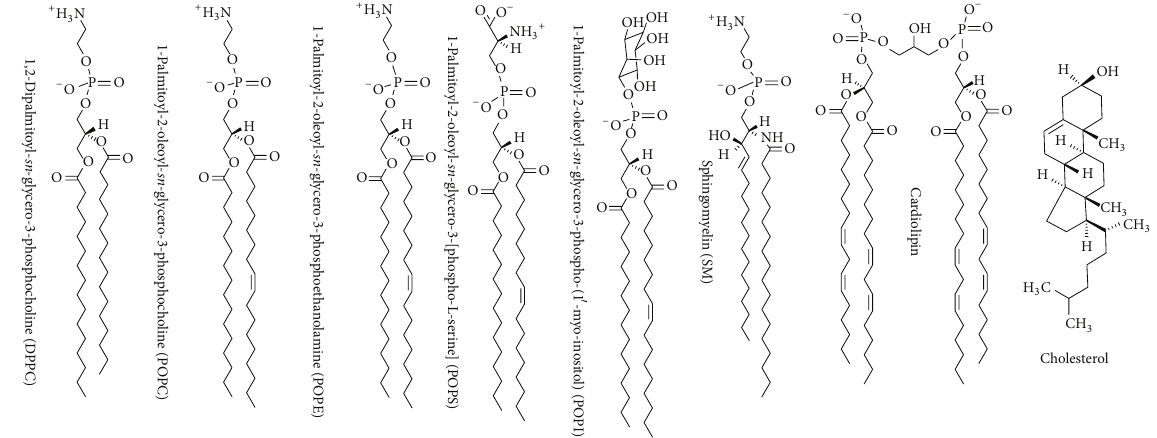
Figure 4: Membrane lipid